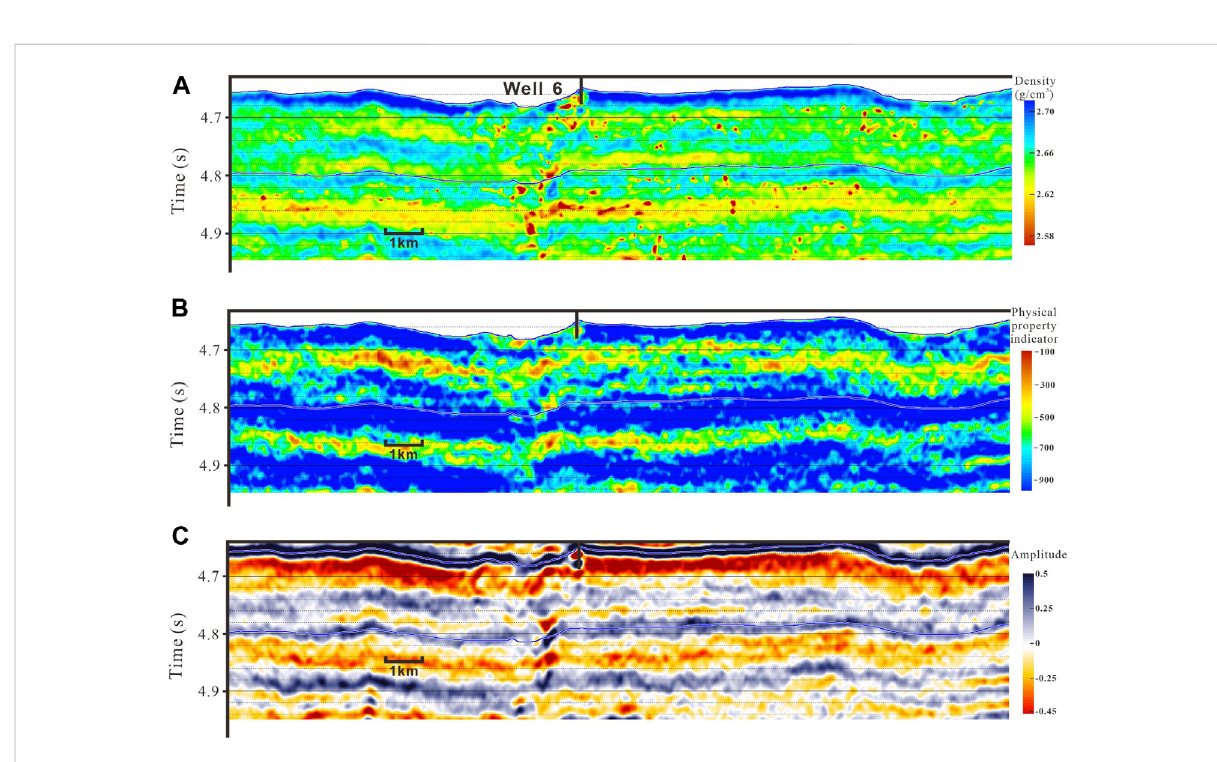
Pro fi les along the N – S direction of Well 6. (A) Density, (B) the physical property indicator, and (C) stack seismic